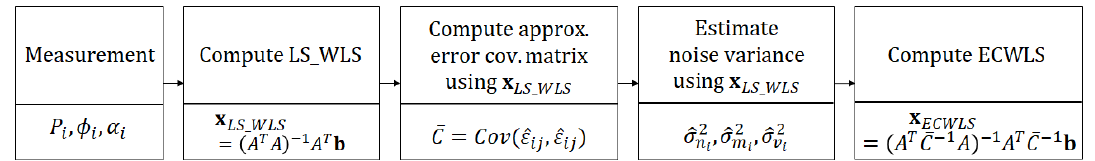
Figure 2. The flowchart of the error covariance weighted least squares (ECWLS)